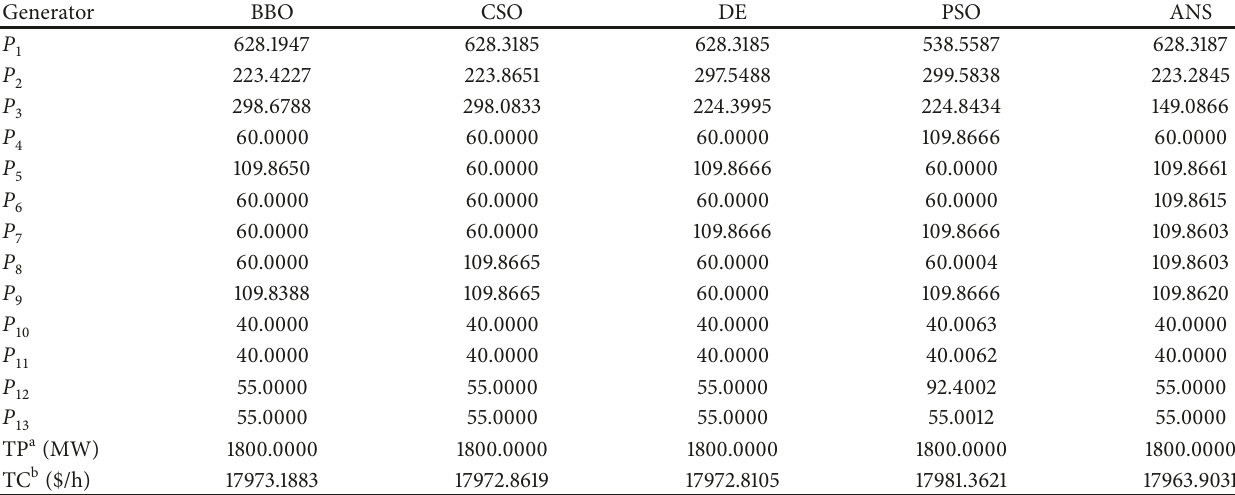
Table 6: Best output power for 13-generator system (Case III).